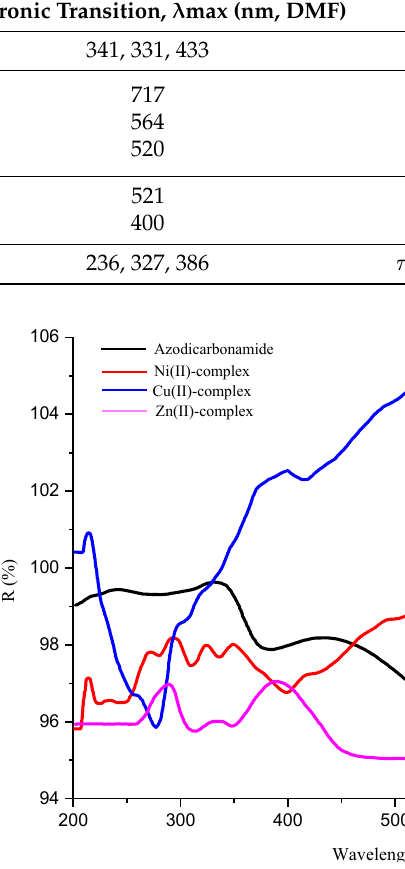
Figure 4. UV-Visible spectra of azodicarbonamide and its metal complexes. Table 4. Absorption data and band assignment of azodicarbonamide ligand and its com- plexes.